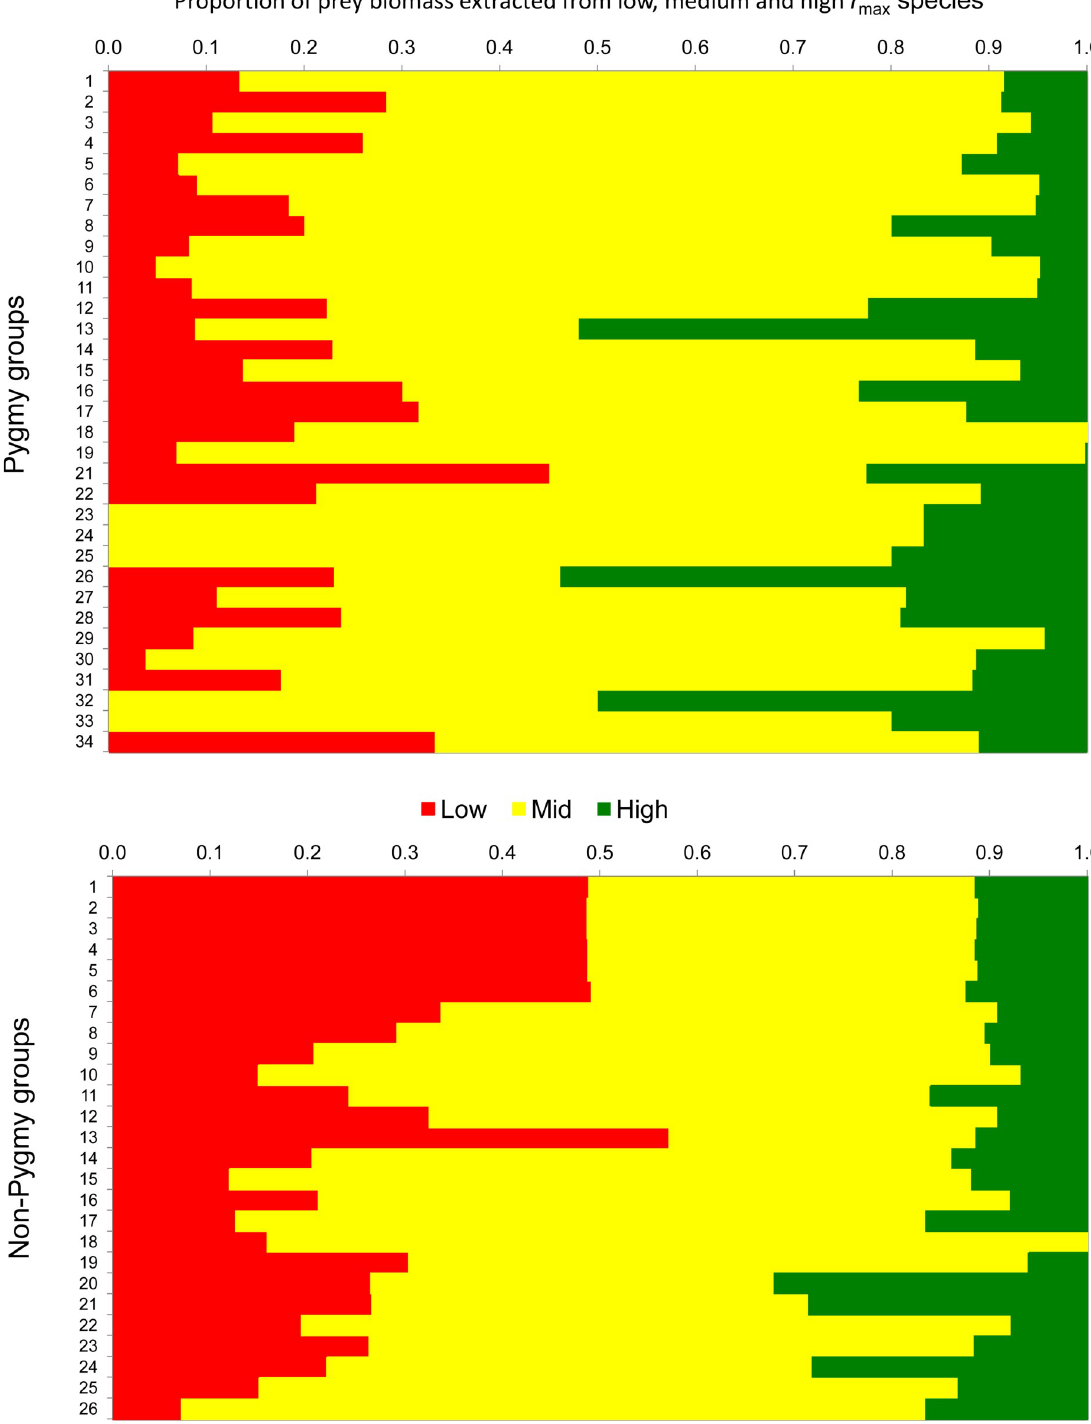
PLOS ONE | https://doi.org/10.1371/journal.pone.0161703 September 2,